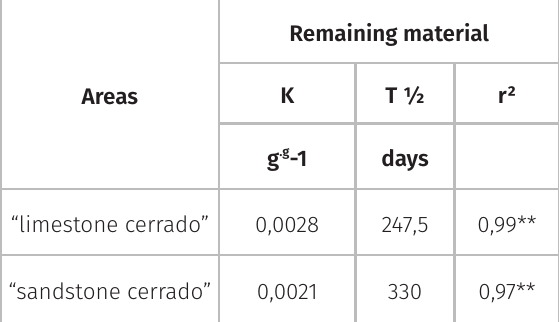
calcium (Ca), magnesium (Mg), organic matter (M.O.), pH = hydrogen potential.